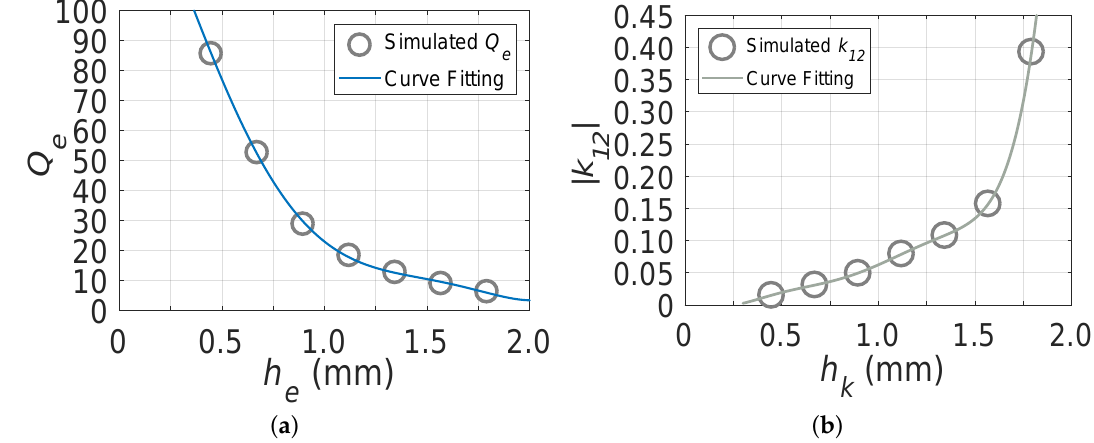
Figure 6. ( a ) Q e and ( b ) k 1,2 variation versus height of stripline probe in the stack-up expressed as layer number ( n qe , n k ).